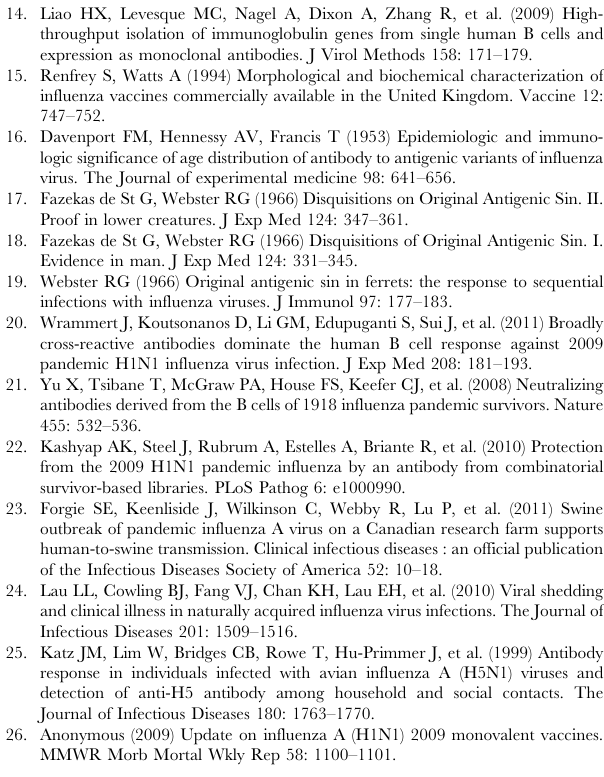
Table S1 Clonal lineages of antibodies from TIV subjects. Table S2 Clonal lineages of antibodies from EI sub- jects. Table S3 Isotypes of isolated influenza-specific rmAbs. Table S4 Isotypes of isolated rmAbs not specific for influenza antigens. Table S5 Heavy chain family usage of influenza-specific rmAbs. Table S6 Heavy chain family usage of isolated rmAbs not specific for influenza antigens. Table S7 Kappa chain family usage of isolated influen- za-specific rmAbs. Table S8 Kappa chain family usage of isolated rmAbs not specific for influenza antigens.